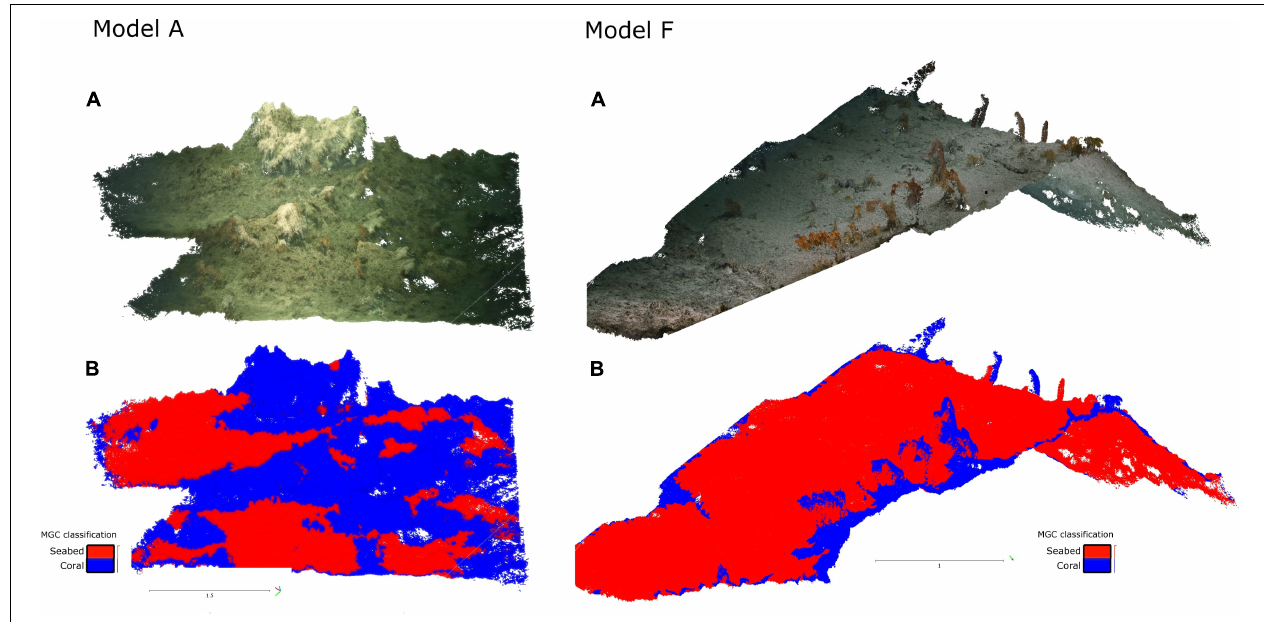
FIGURE 6 | Model F – Results of classification using the MGC method – (A) Dense cloud (B) Classification output. Model with predominance of black corals (Leiopathes sp.) Red is seabed and blue is coral. Model A – Results of classification using the MGC method – (A) Dense cloud (B) Classification output. Model with predominance of coral rubble patterns. Red is seabed and blue is